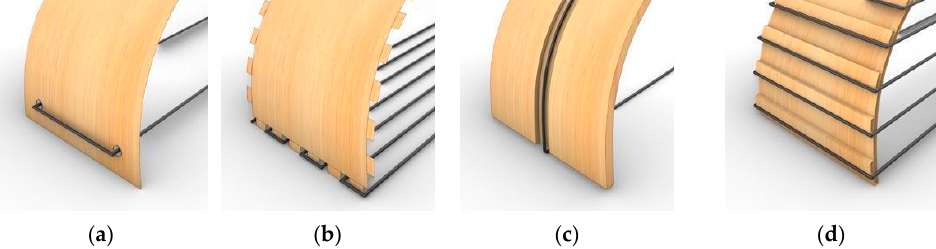
Figure 15. Development of the timber–fibre connections through subtractive methods at edges: ( a ) subtractive holes; ( b ) subtractive teeth; ( c ) subtractive long-edge grooves; ( d ) additive short-edge grooves.